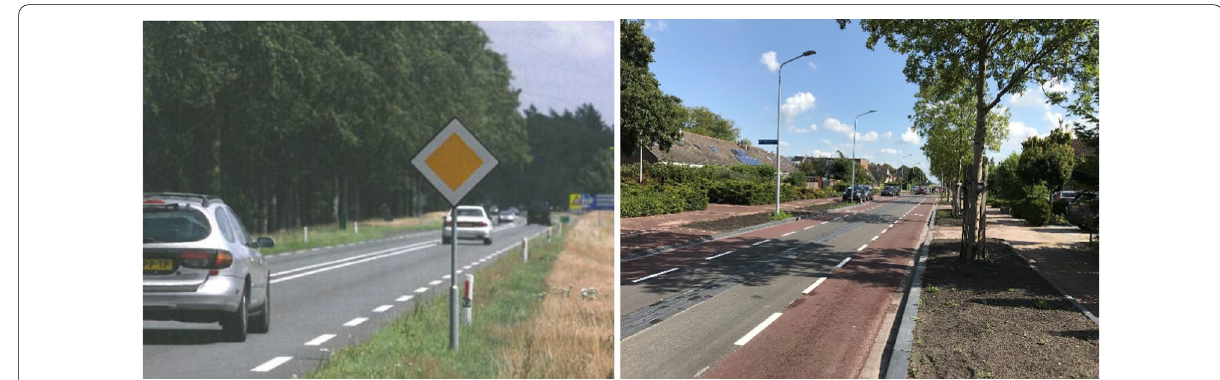
Fig. 5 On the left a distributor road with double-line center markings and on the right an access road with red asphalt marking the bike